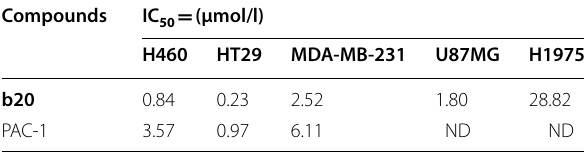
ND not determined